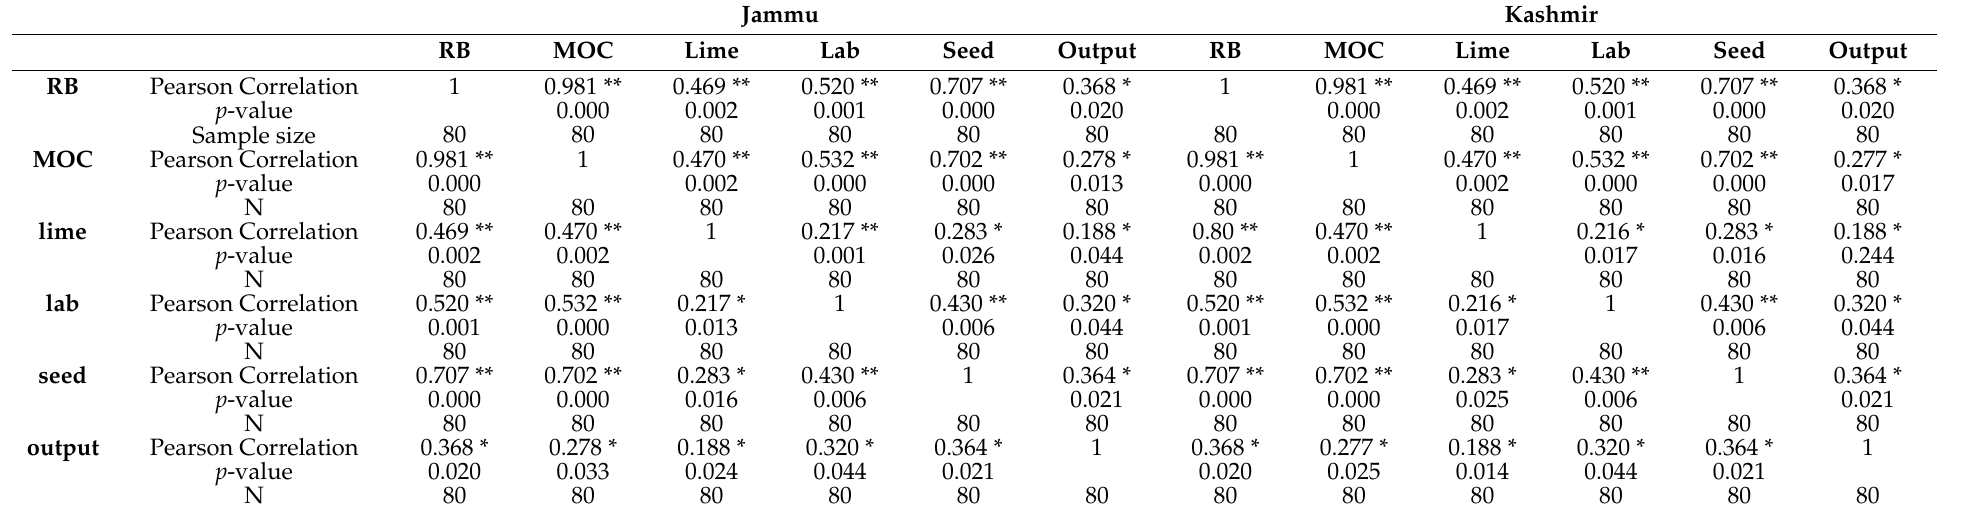
Table 4. Correlation coefficient between